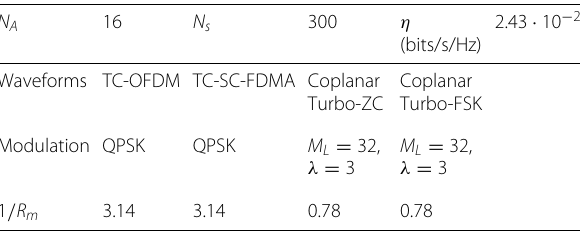
Table 3 Parameters for the second scenario. The data rate is equal to 46.68 kbps N A 16 300